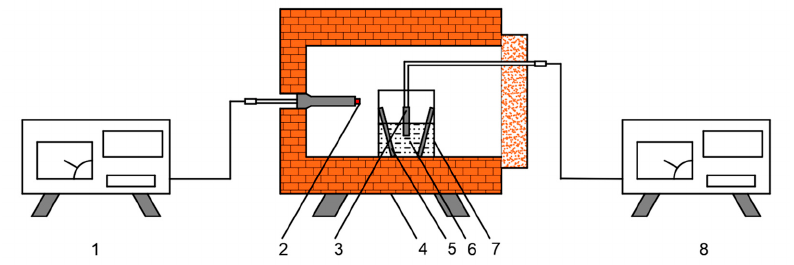
Figure 5. Schematic diagram of molten Zn immersion tester: (1,8) temperature control; (2,3)